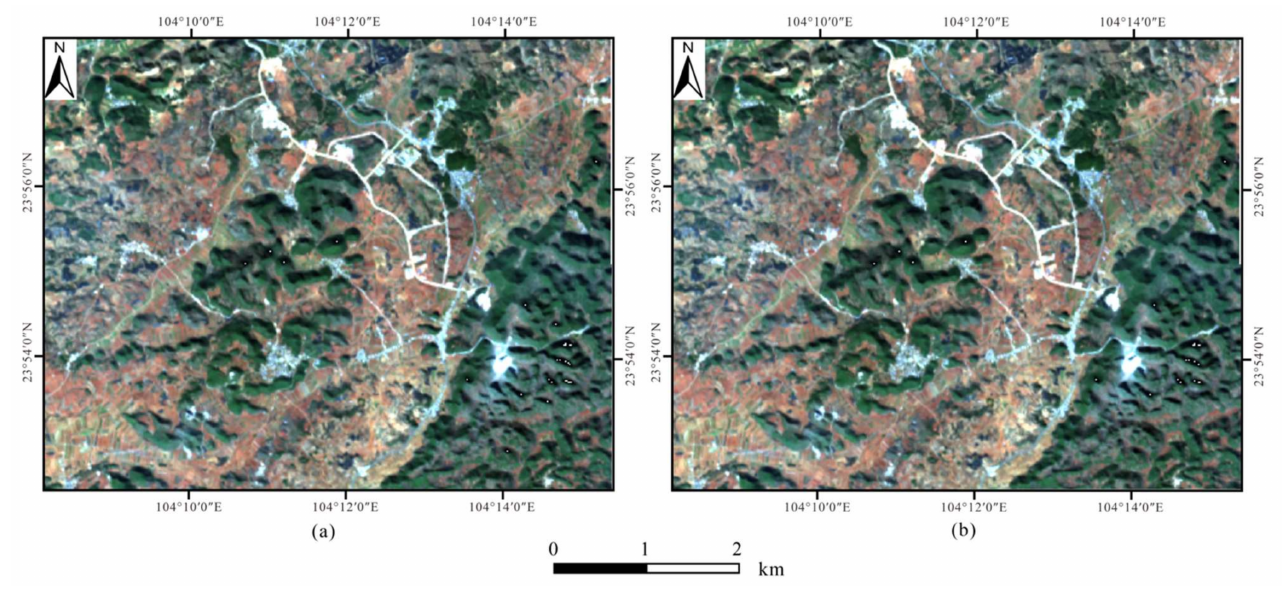
Figure 9. ( a ) Image processed by radiometric calibration and FLAASH; ( b ) image processed by the S-G